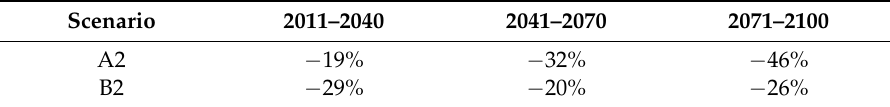
Table 2. Variation of available resource (runoff) based on CEDEX average projections for the Guadalquivir, compared with 1961–1990. Scenarios A2 and B2. Source: CEDEX, 2012.